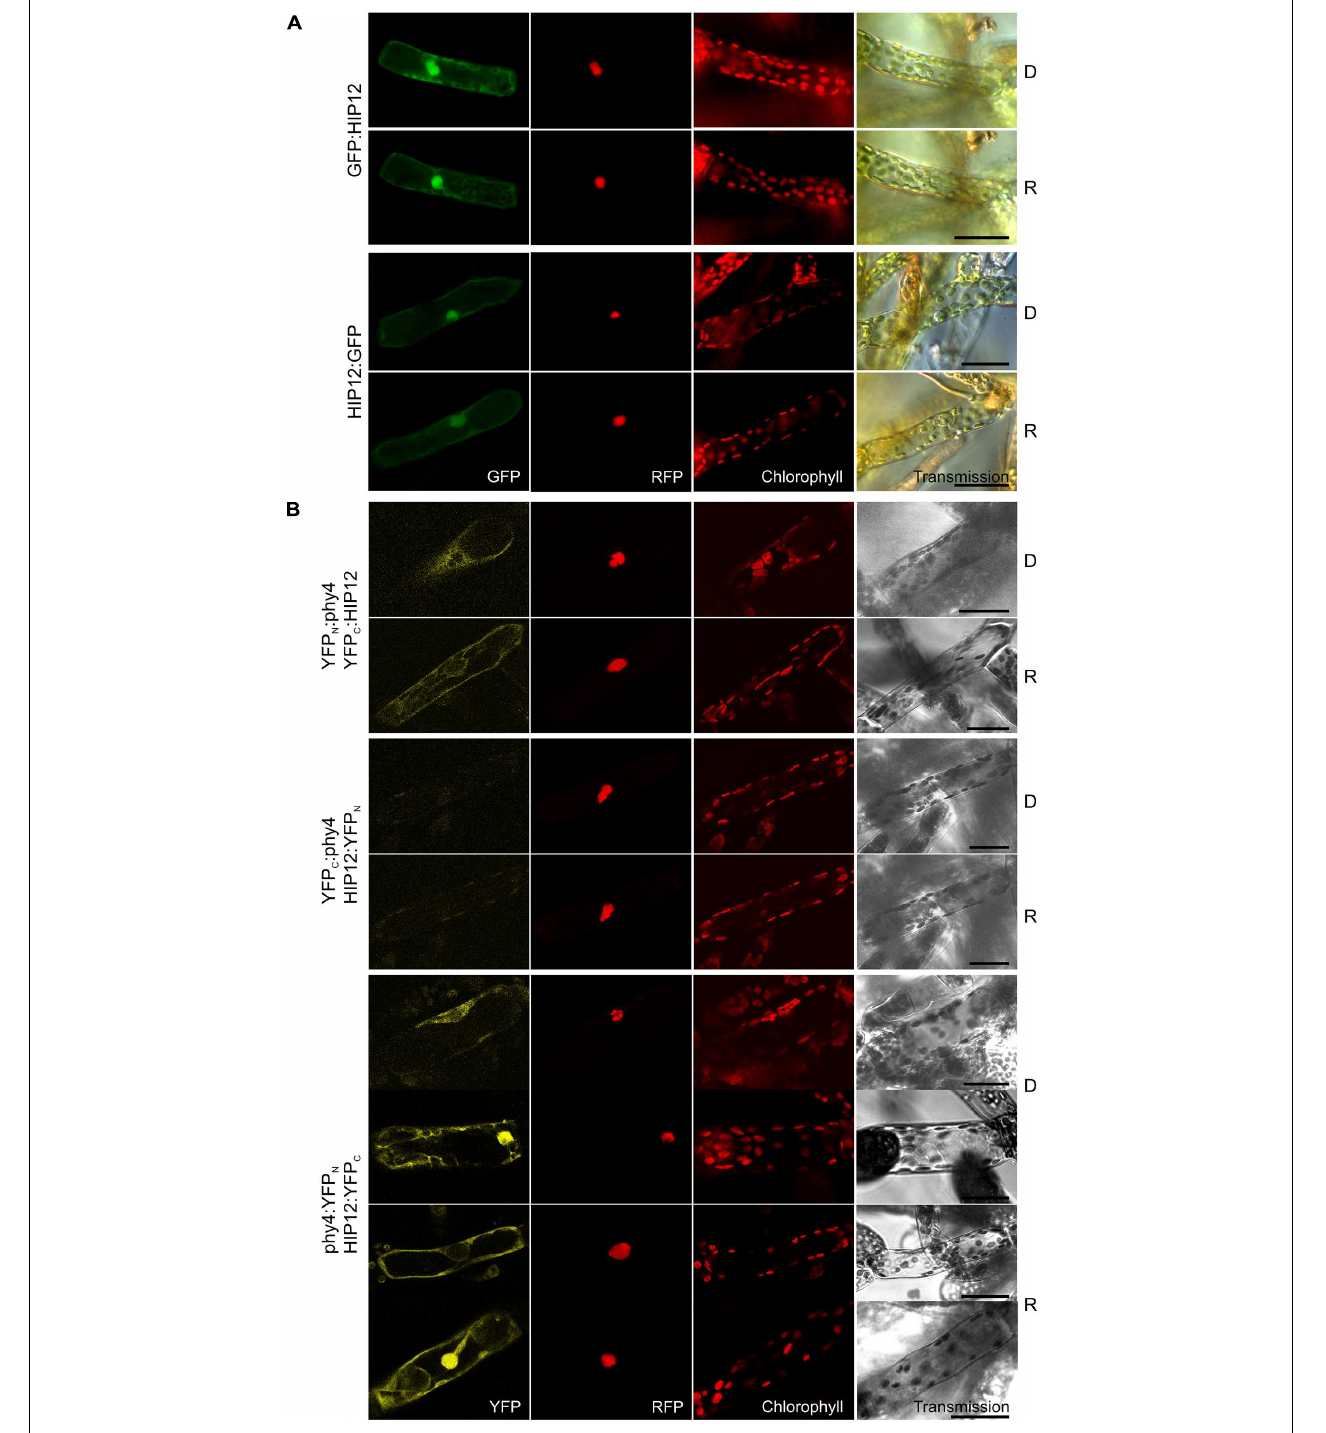
FIGURE 10 | HIP12 (Pp3c13_15620V1.1) intracellular localization (A) and split-YFP-studies of HIP12–phy4 interaction (B) each without (D) and with R pre-treatment (R) using fluorescence- and confocal microscopy, respectively. Overall figure structure is analogous to Figure 1 . (A) N-and C-terminally GFP-tagged HIP12 localized to nucleus and cytoplasm (rows 1 and 2; and 3 and 4, respectively; column 1, GFP). In some cases the HIP12:GFP signal was confined largely to the cytoplasm (not shown). (B) All four split-YFP configurations were tested, however, YFP N :phy4–HIP12:YFP C and phy4:YFP N –YFP C :HIP12 were excluded because the respective negative controls showed significant signals. Thus the following configurations are shown: YFP N :phy4–YFP C :HIP12 (rows 1 and 2), YFP C :phy4–HIP12:YFP N (rows 3 and 4) and phy4:YFP N –HIP12:YFP C (rows 5–8; two distinct patterns in both conditions). All configurations except YFP C :phy4–HIP12:YFP N yielded significant cytoplasmic or nucleo-cytoplasmic signals (column 1, YFP). Scale bars 30 µ m.